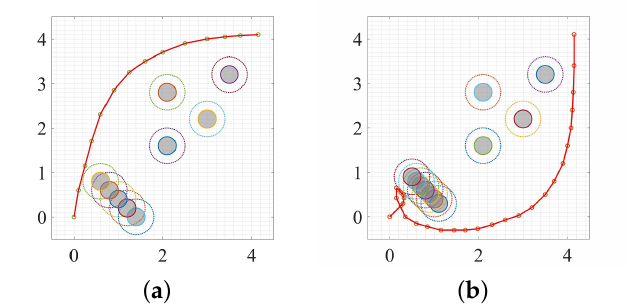
Figure 13. The robot uses path planner in robot operating system (ROS) to avoid a ( a ) slow and ( b ) fast moving obstacle in the dynamic environment.